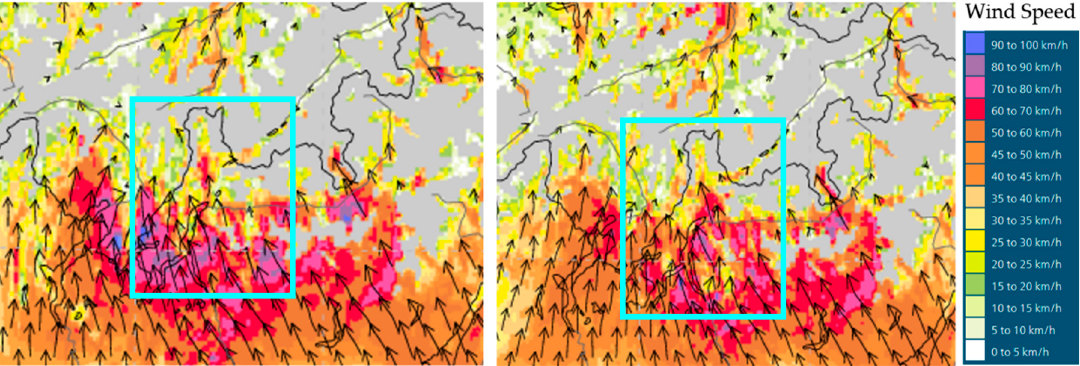
Figure 3. Low-level wind convergence (blue boxes) recorded in the study area at 2000 m, © Meteo Swiss [45], during the night of 12 June at 3:00 and 4:00.